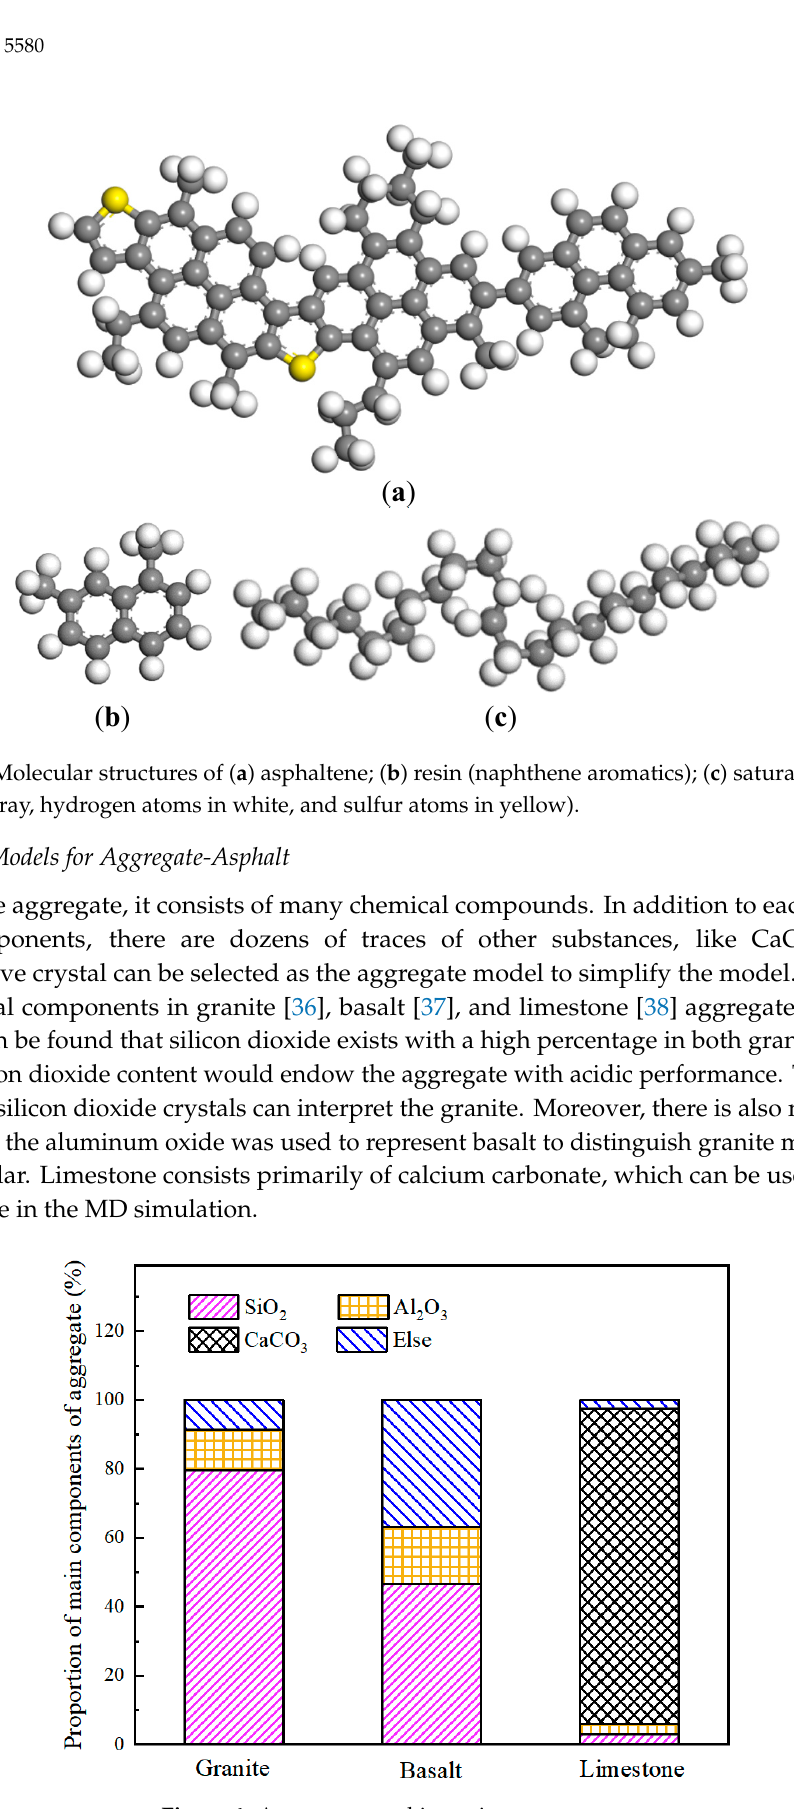
Figure 4. Aggregates and its major component.